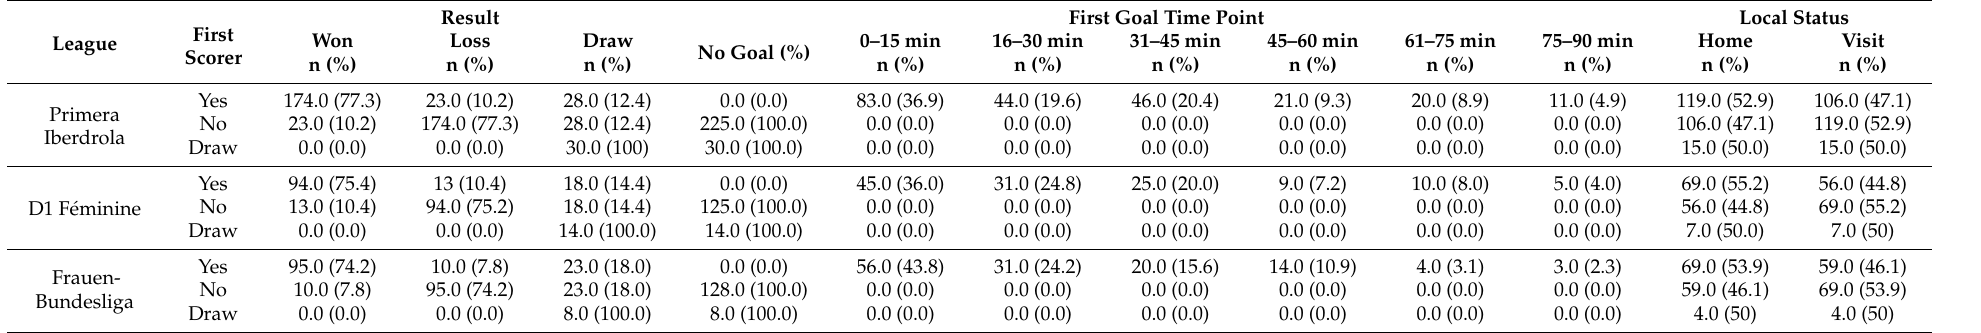
Table 1. Descriptive analysis of the result, time point when the first goal was scored, and local status by the league and first